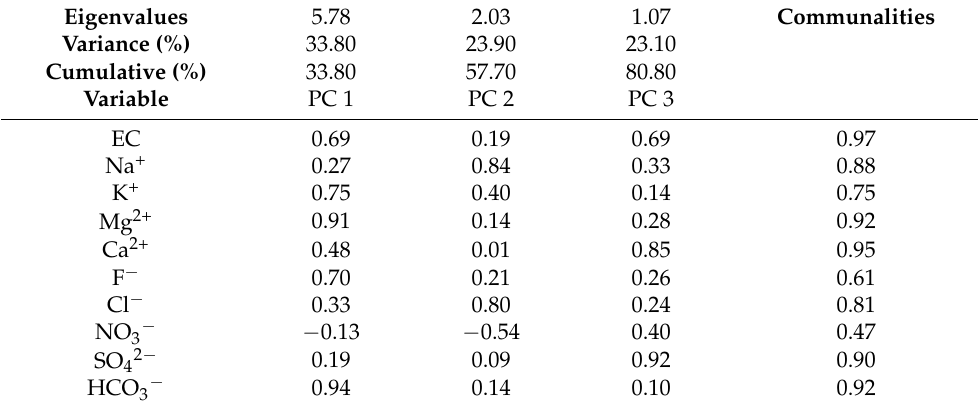
Table 2. Varimax rotated component matrix for water ions in Chishui River.